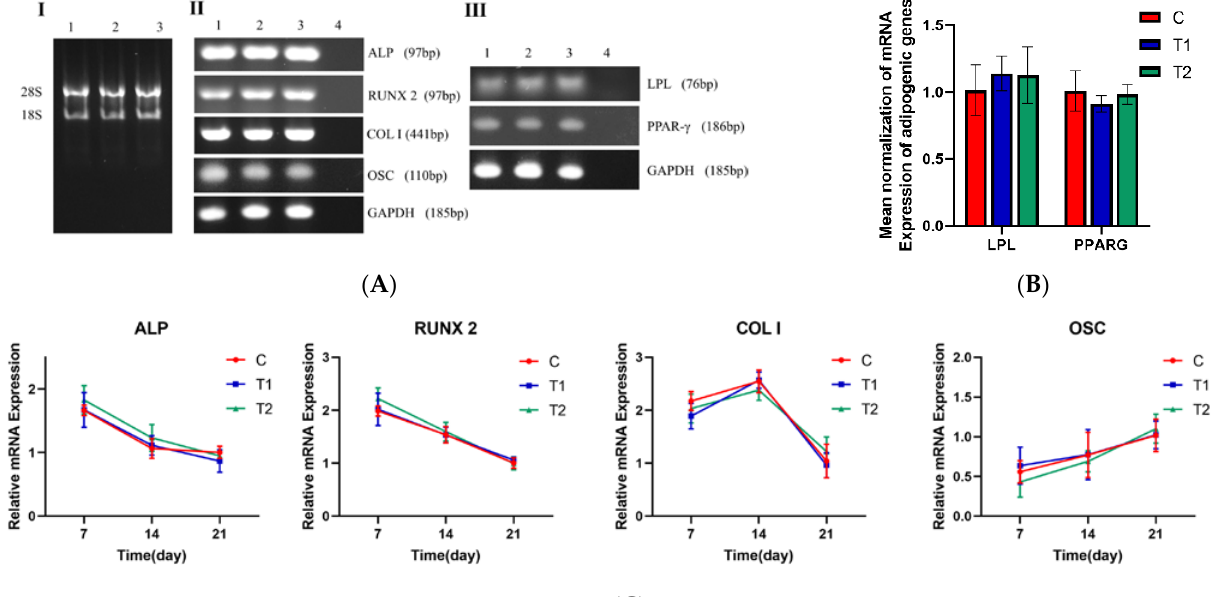
Figure 7. Representative gene expression profile in different groups. ( A ) Gel electrophoresis results.